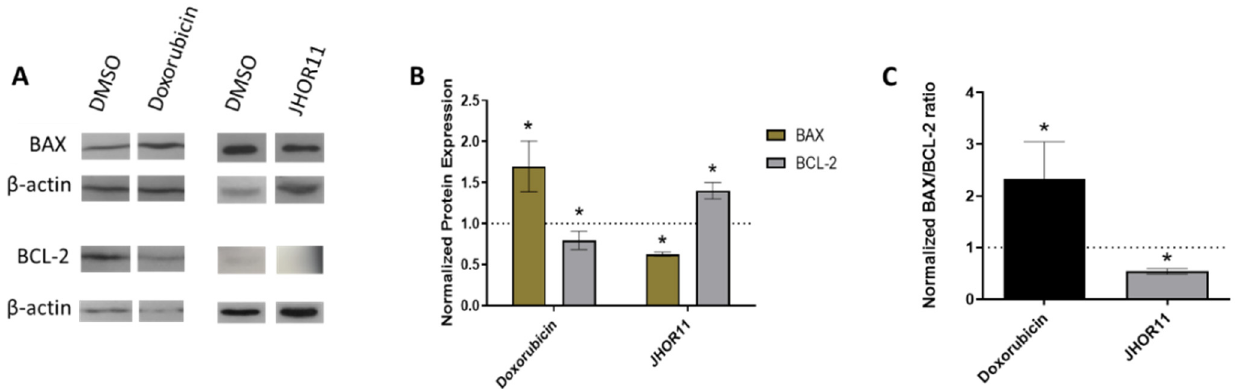
Figure 4. Quantification of apoptotic index of A2780 cells. ( A ) Western blot for quantification of BAX, BCL-2 and β -actin in A2780 cells after 48 h incubation with IC 50 of JHOR11, 0.1 μ M Doxorubicin as positive control or 0.1% ( v / v ) DMSO (control). ( B ) BAX and BCL-2 protein expression after normalization to respective β -actin and control. The value of the control is represented as a dotted line. ( C ) Apoptotic index calculated by BAX/BCL-2 ratio. The value of the control is 1, represented as a dotted line. Bars represent the average ± SD of three independent experiments. * p value < 0.05 relative to control.